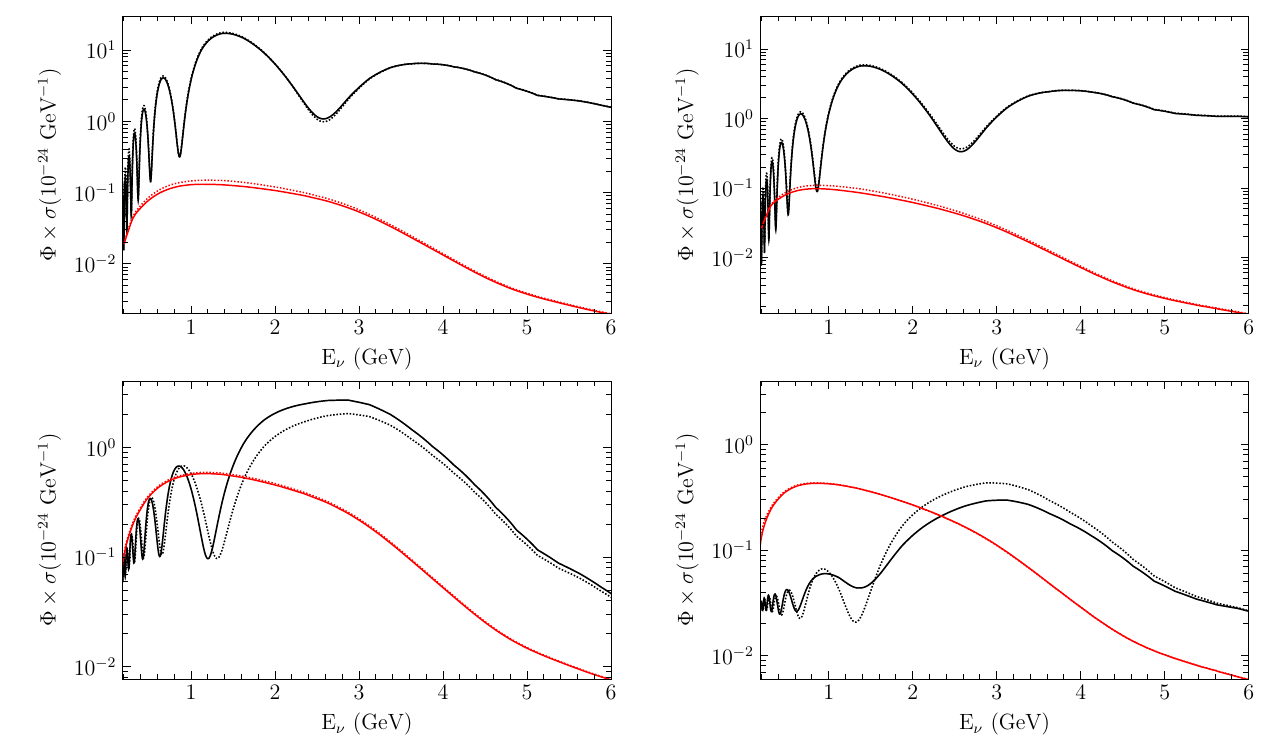
to ID and VD, respectively. Solid lines consider matter effects, while dashed lines show an equivalent scenario in vacuum